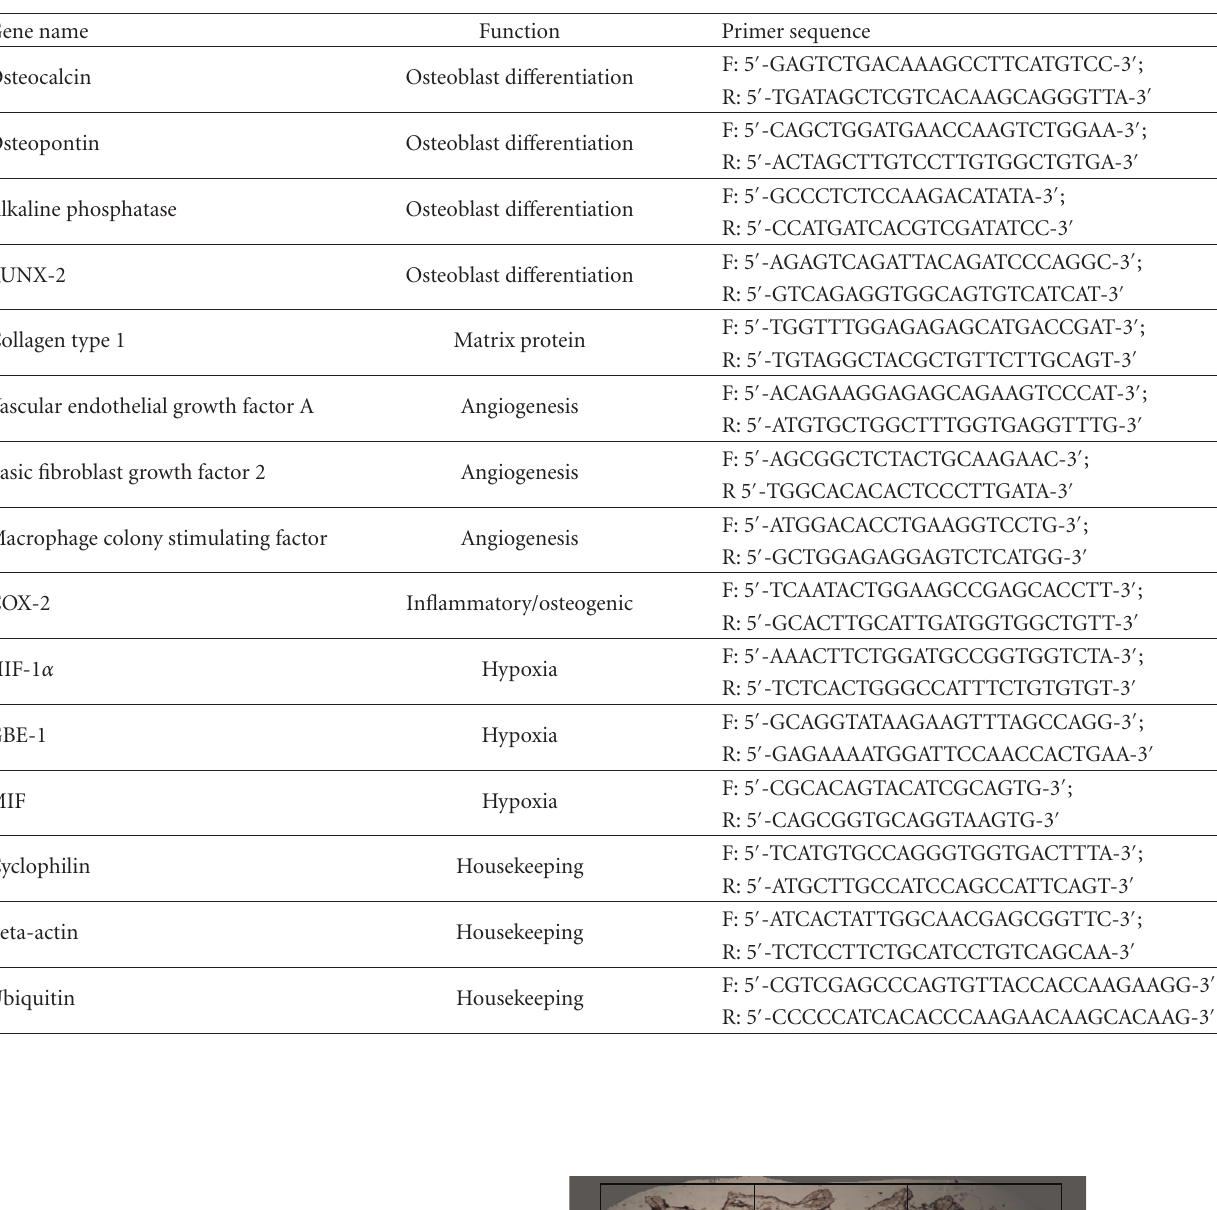
Table 1: Primer sequences and roles for genes measured in three-dimensional perfusion studies.